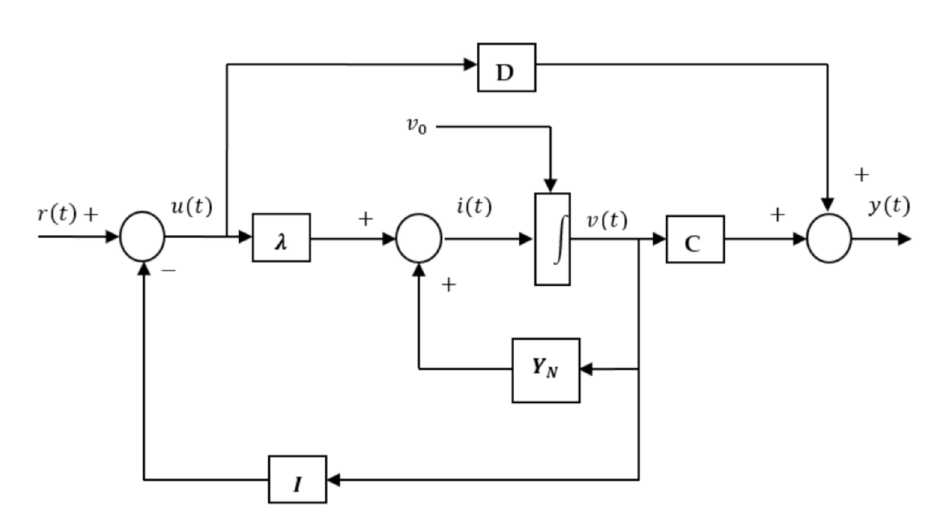
Figure 3. Closed-loop system block diagram of eigenvalue-compensated transmission network.